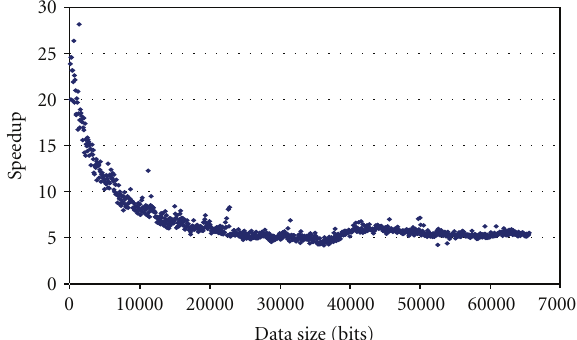
Figure 12: Addition/subtraction hardware speedup versus GMP